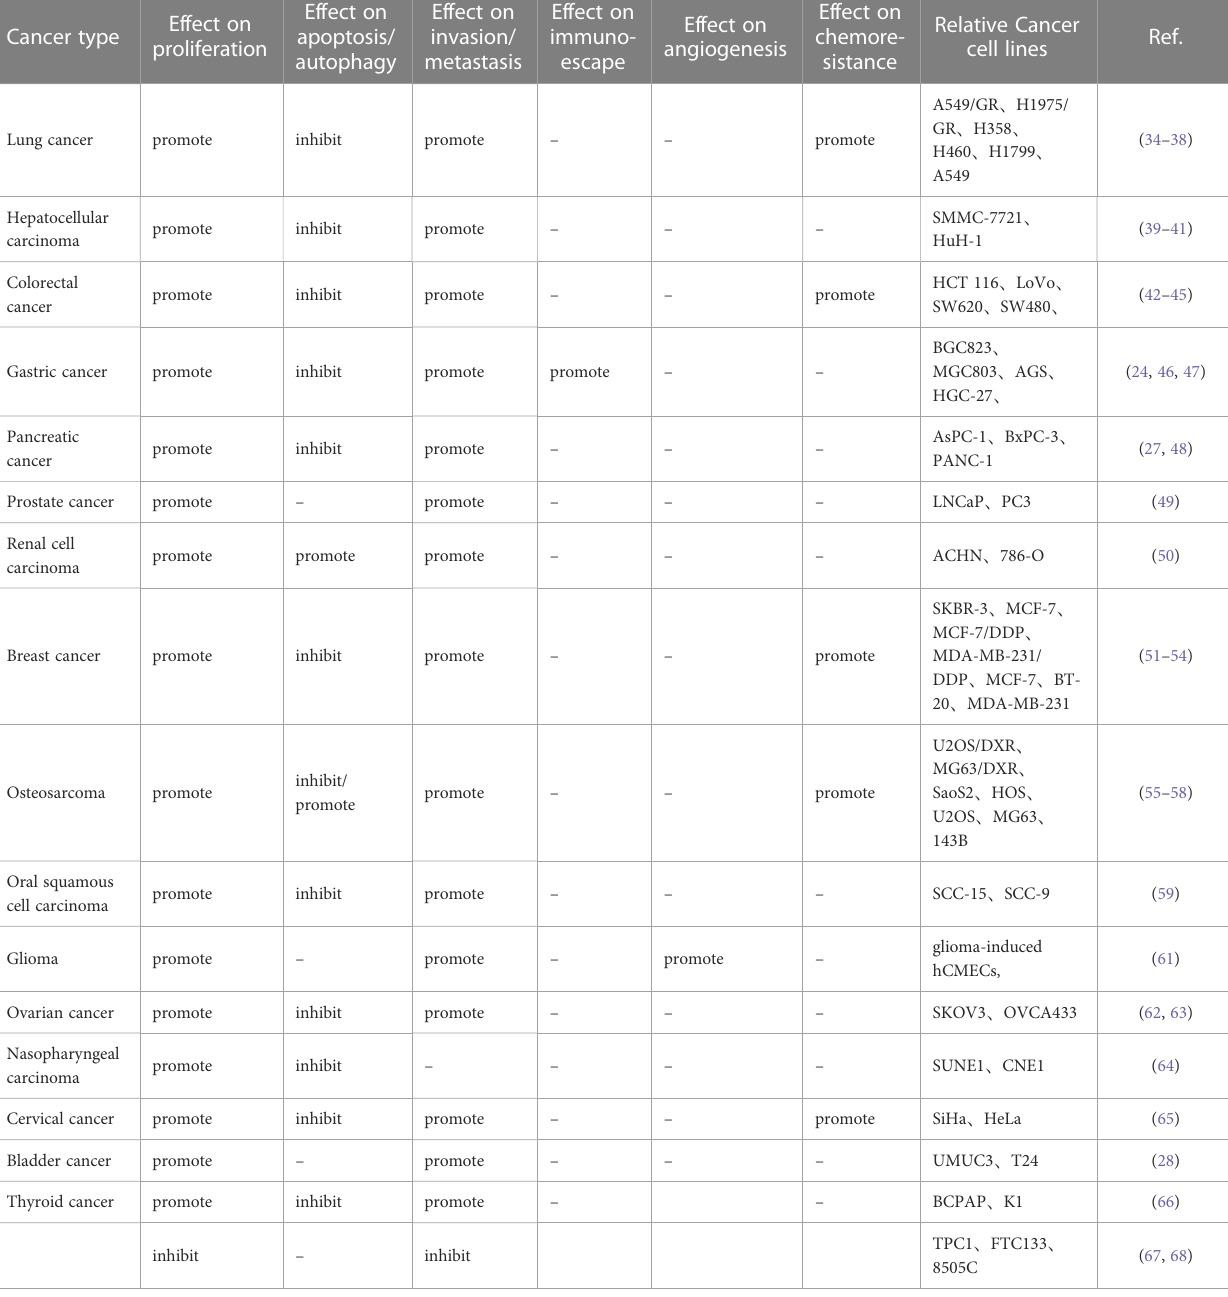
TABLE 2 In vitro functional characterization of SNHG15 in